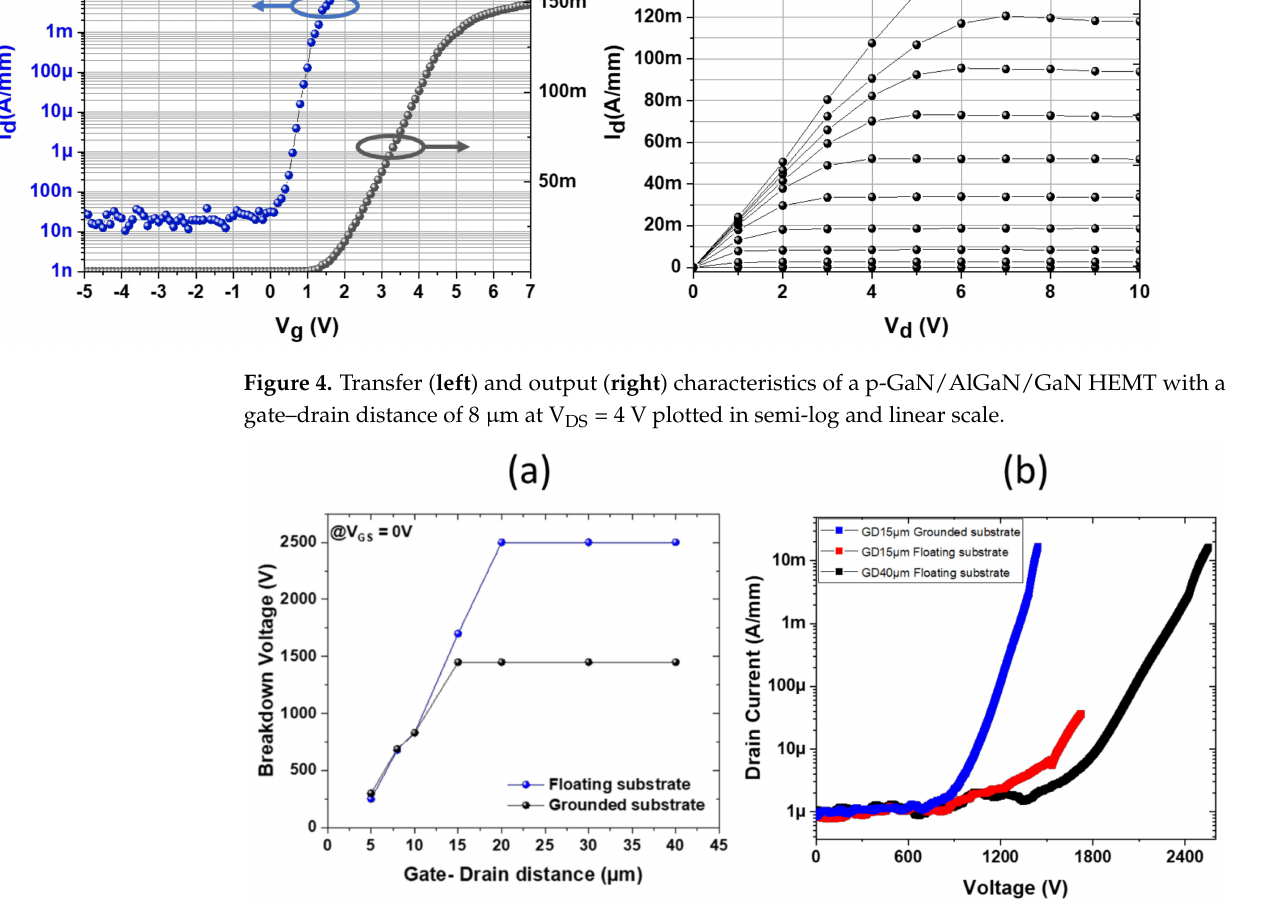
Figure 5. Three-terminal breakdown voltage at V GS = 0 V of p-GaN/AlGaN/GaN HEMTs with floating and grounded substrate: ( a ) as a function of the gate-to-drain distance and ( b ) for various gate-to-drain distances.